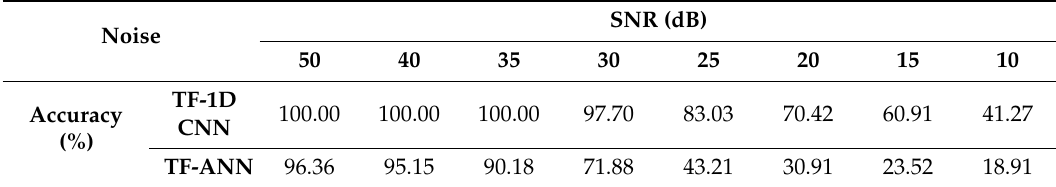
Table 3. Comparison between the TF-1D CNN and TF-artificial neural network (ANN) framework in noisy environments under di ff erent noise